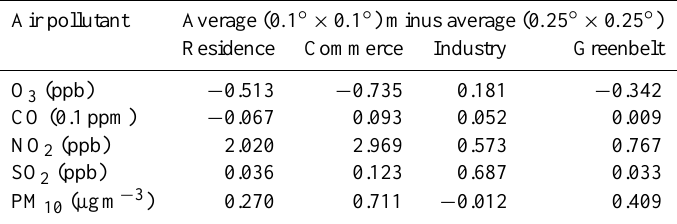
Table 8. Comparisons of the climatological annual averages over South Korea during 2002–2013, based on the two types of spatial-scale analyses of the 0 . 1 ◦ × 0 . 1 ◦ and 0 . 25 ◦ × 0 . 25 ◦ grids. The 0 . 1 ◦ × 0 . 1 ◦ grid averages (compared to those of 0 . 25 ◦ × 0 . 25 ◦ ) generally tend to show the characteristics in big urban cities rather than in small suburban cities, because the air pollution monitoring stations are more densely located in the former areas.